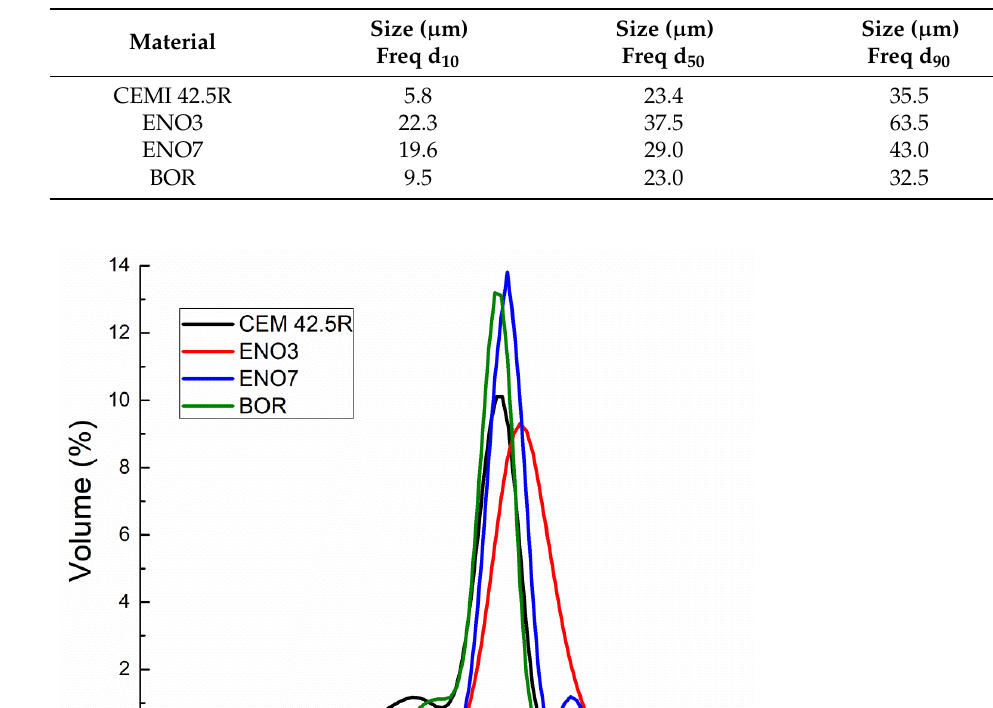
Table 5. Particle size distribution parameters.